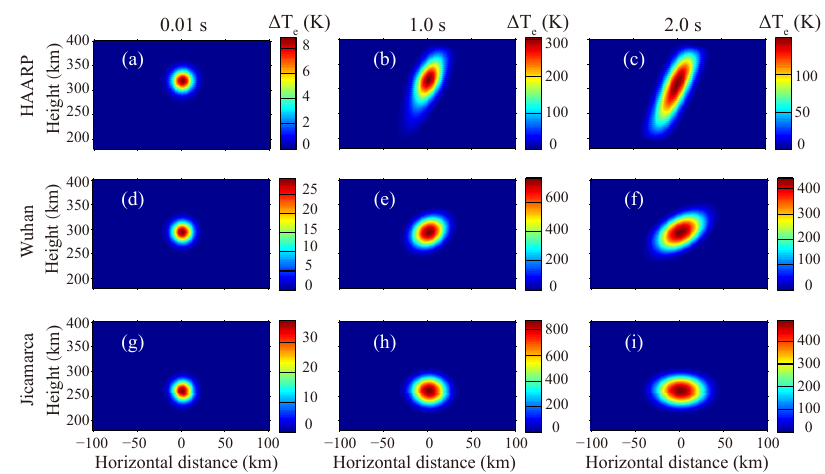
Figure 2. Contours of electron temperature changes with modulation frequency of 0.5Hz at heating time of 0.01, 1.0 and 2.0s in the nighttime ionosphere.